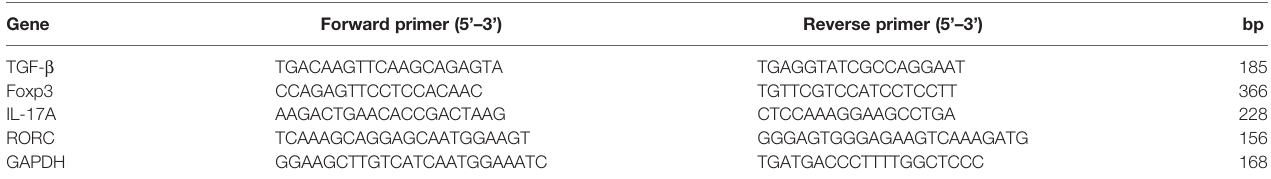
TABLE 1 | Primer sequences for genes targeted in